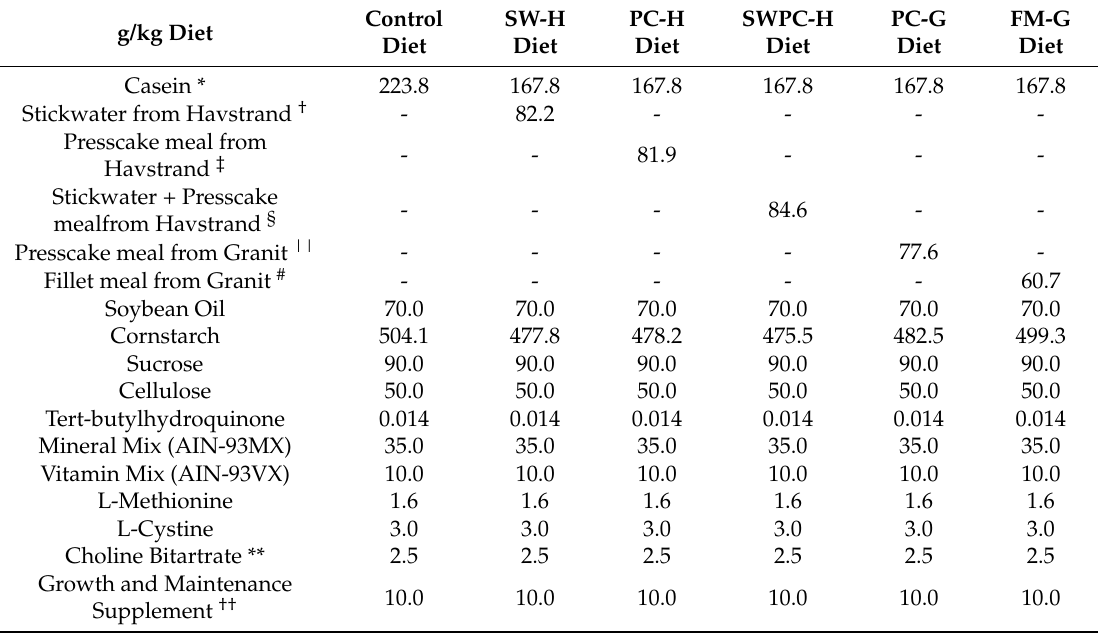
Table 1. Composition of the experimental